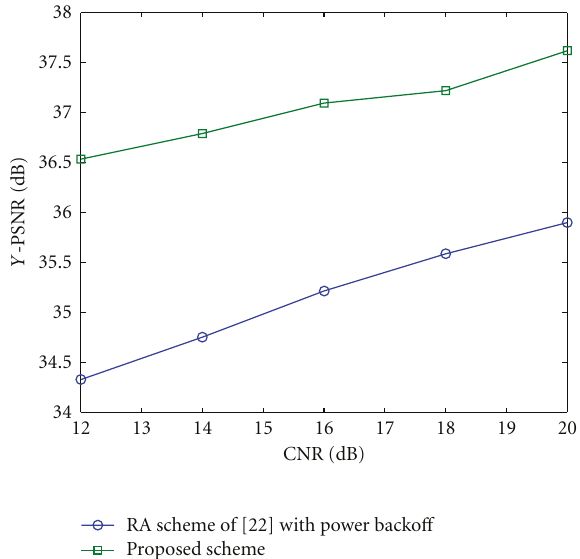
Figure 9: PSNR plot comparing RA schemes with power backo ff and proposed allocation scheme for a system with 128 subcarriers, and 3 users, each user receiving the city